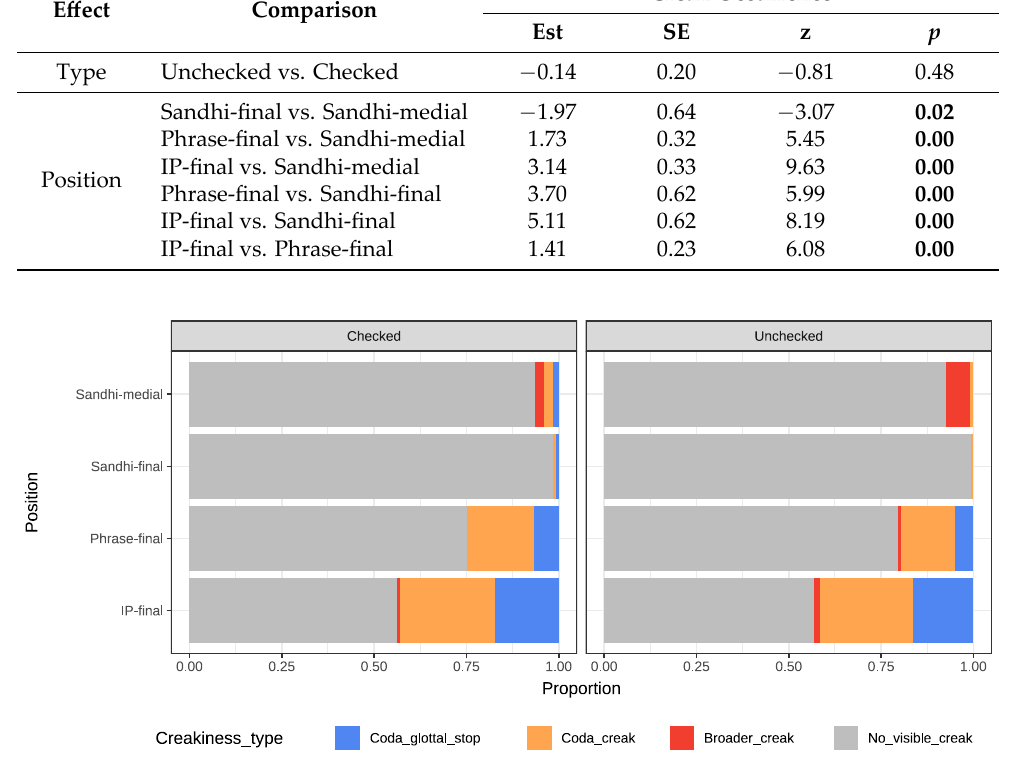
Figure 10. The distribution of tokens with three different types of creak (coded in non‑gray colors) and tokens without visible creak (coded in gray) among checked and unchecked tones at various prosodic